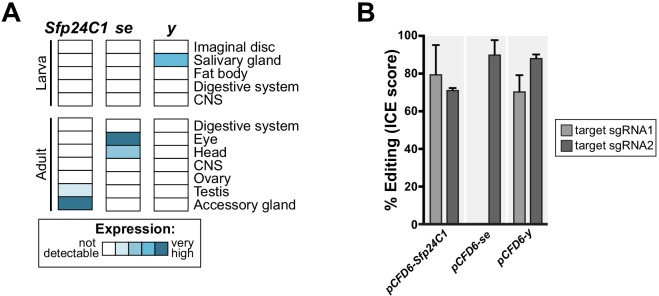
Negative control sgRNA transgenes for use with HD_CFD library.(A) Sfp24C1, se and y are not expressed in most tissues (upper panel, data from modENCODE), making them suitable as negative controls in most circumstances. (B) sgRNA lines mediate efficient mutagenesis at both (pCFD6-Sfp24C12x, pCFD6-y2x) or one (pCFD6-se2x) target sites.